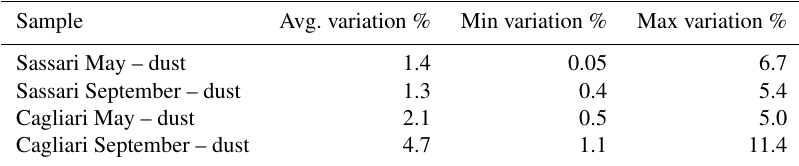
Table 2. Extent of OTU change across cell harvesting time during the same dust outbreak sampling. The percent variation (either increase or decrease) of a given OTU’s abundance between the values found in the community obtained by the first 12h sampling and the ones resulting from the following 12h lapse was computed. The average, minimum, and maximum percent variations between counts are shown. Only taxa displaying a difference in percentages higher than half of their standard deviation were selected for the present comparison.